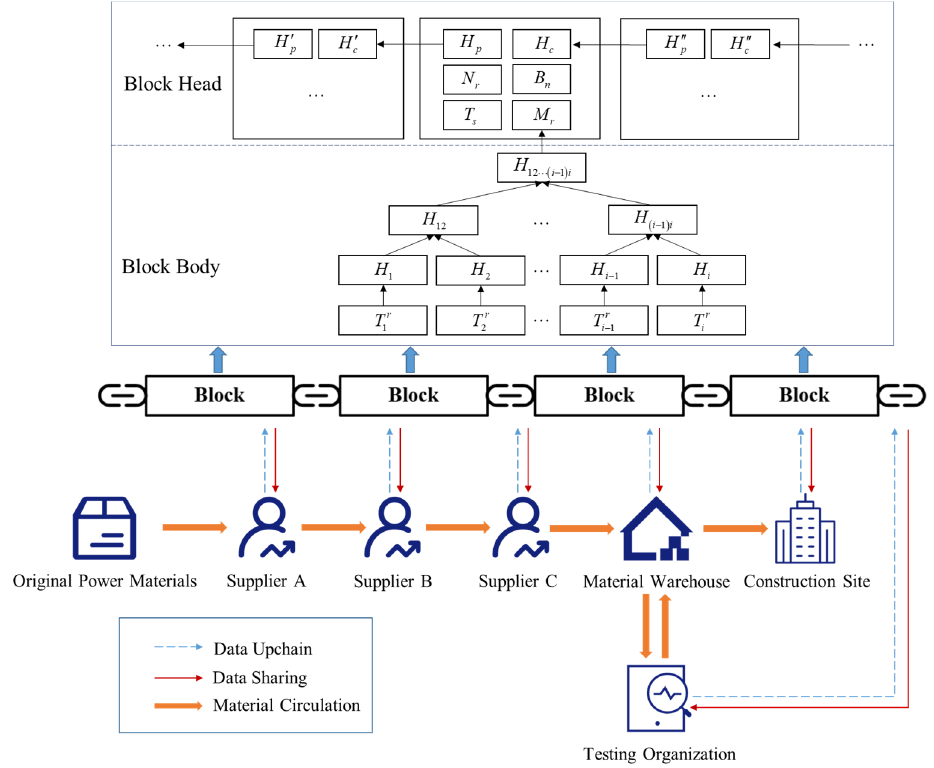
Figure 4. Data traceability mechanism for inspection and distribution of power material based on blockchain.